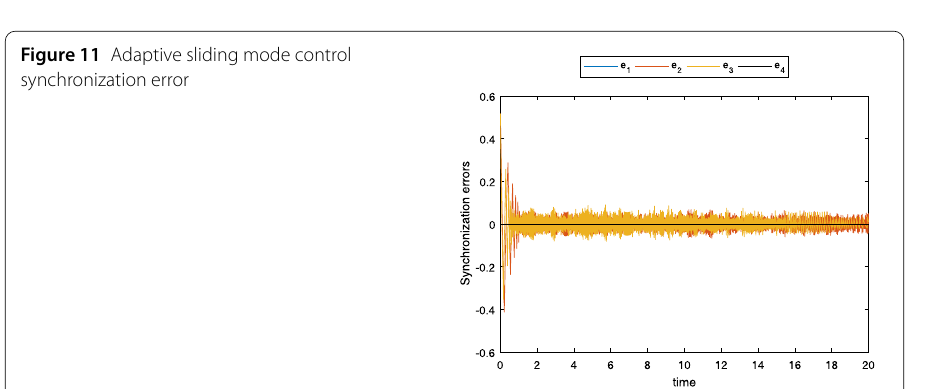
Figure 10 Adaptive sliding mode control synchronized trajectories